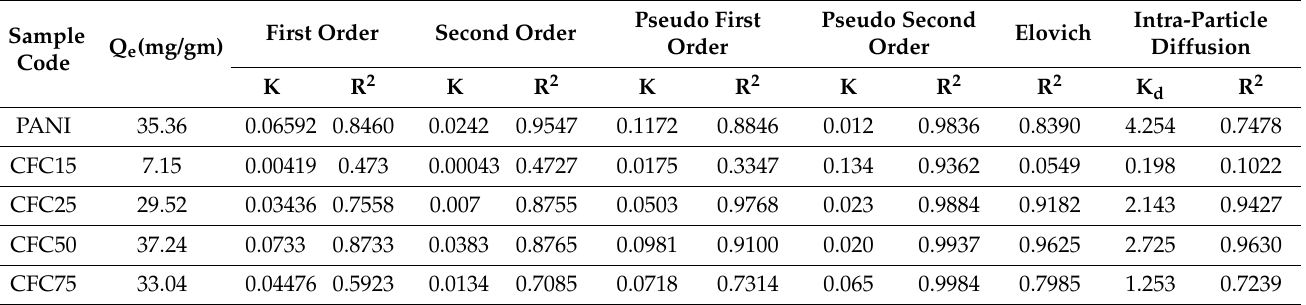
Table 3. The values of K and R 2 of different kinetic model fittings for the adsorption of Cr(VI) onto the prepared samples.